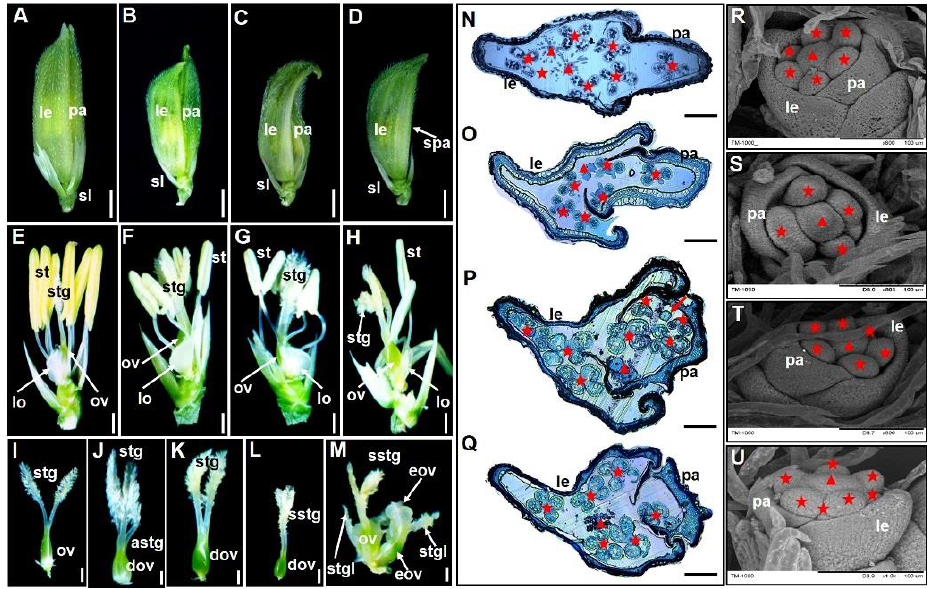
Figure 2. ( A ) A wild-type spikelet. ( B – D ) sll1-ZH spikelets. ( B ) Spikelet with c racked glumes. ( C ) Spikelet with olecranoid lemma and invaginated palea. ( D ) Spikelet with shrunken palea. ( E ) Inner floral organs of the WT floret ( F – H ) sll1-ZH florets with six stamens ( F ), five stamens ( G ), four stamens with reduced size ( H ). ( I – L ) Macrophotographs of stigmas from the florets in E – H . ( M ) The innermost whorls of one spikelet have extra stigma-like organs and ovary-like organs in the sll1-ZH mutant. ( N – Q ) Transverse paraffin sections of spikelets from WT ( N ) and the sll1-ZH mutant ( O – Q ). O , Thickened lemma and palea with normal number of stamens and stigmas. ( P ) Thine lemma and thickened palea with one ovary but seven stamens. The red arrow indicates uncertain structure. ( Q ) Thine lemma and thickened palea with the normal numbers of stamens and stigmas. ( R – U ) Scanning electron microscope (SEM) observation of early floral organ development in WT ( R ) and the sll1-ZH mutant ( S – U ). ( S ) Four stamen primordium. ( T ) Normal six stamen primordium. ( U ) Seven stamen primordium. Red asterisks in ( N – U ) indicate the stamens, and triangles indicate the stigmas. astg, additional stigma; dov, dilated ovary; eov, extra ovary-like structure; le, lemma; lo, lodicule; ov, ovary; pa, palea; sl, sterile lemma; spa, shrunken palea; st, stamen; stg, stigma; stgl, stigma-like organ; sstg, shriveled stigma. Scale bars = 2 mm ( A – D ), 1 mm ( E – M ), 500 μm ( N – Q ) and 100 μm ( R – U ).